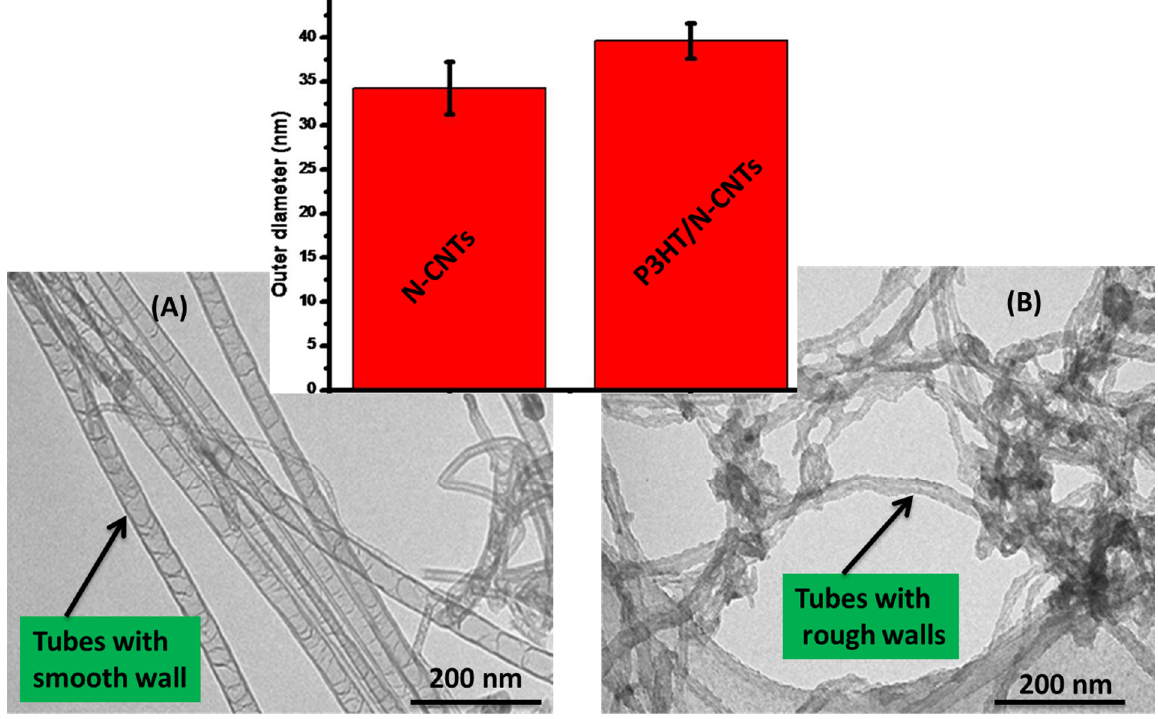
Figure 1. TEM images of ( A ) purified N-CNTs; and ( B ) N-CNT/P3HT nanocomposite synthesized by in situ polymerization (inset comparison of outer